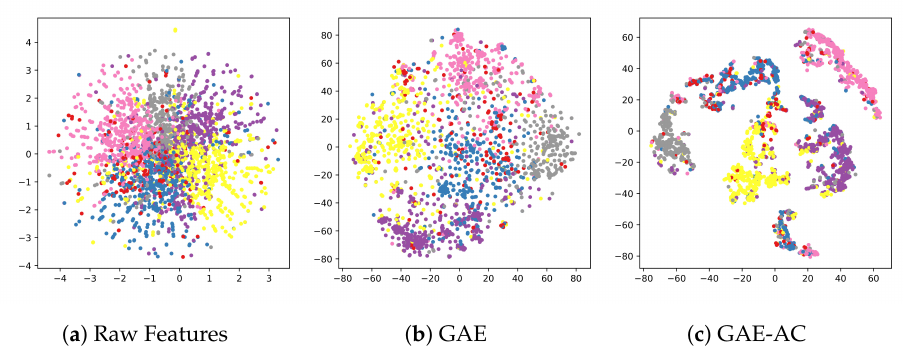
Figure 5. Two-Dimensional (2D) visualization results on Citeseer